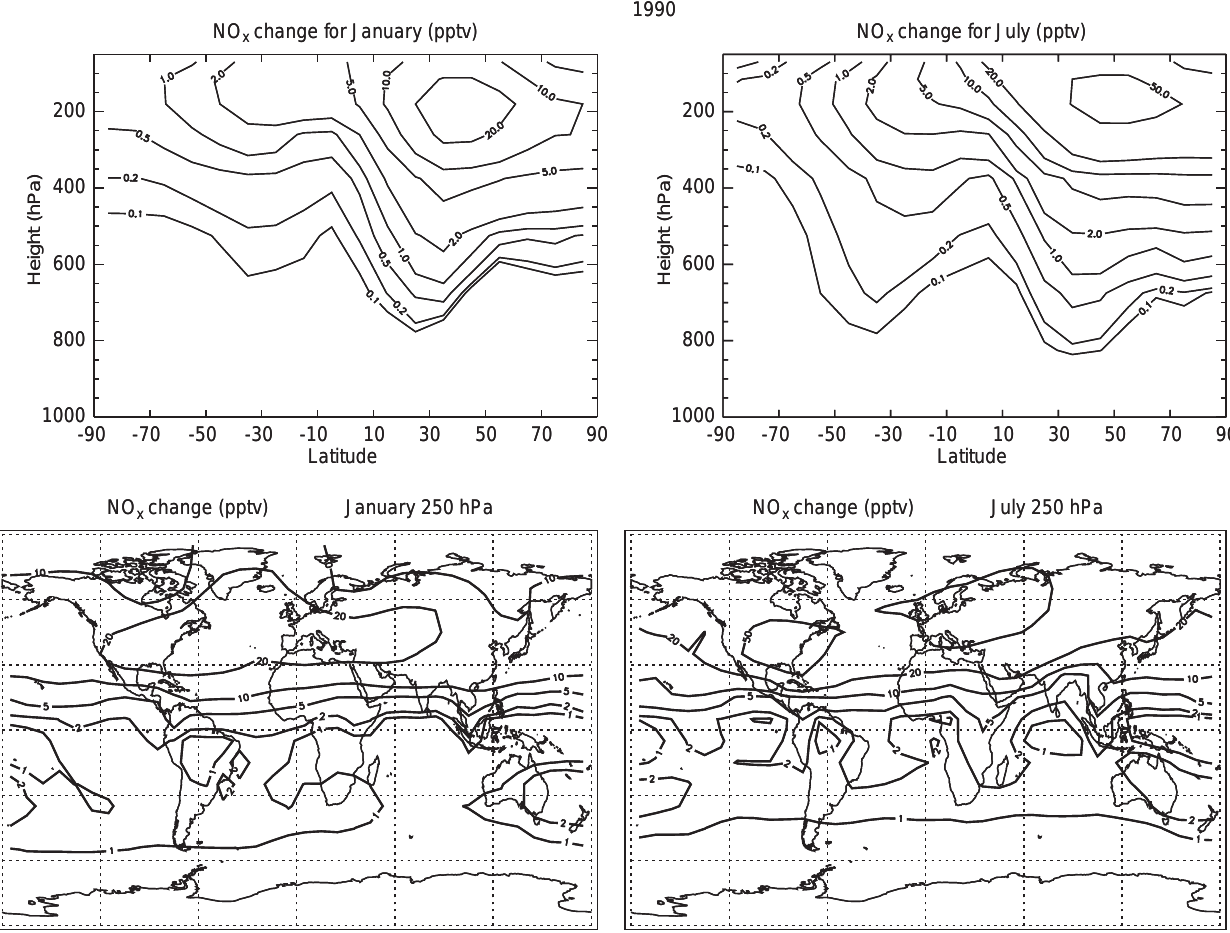
Fig. 3. NO perturbation for January and July due to aircraft emissions for the reference year 1990. Top shows the zonally-averaged NO x perturbation (pptv). The lower panels show the distribution of the NO